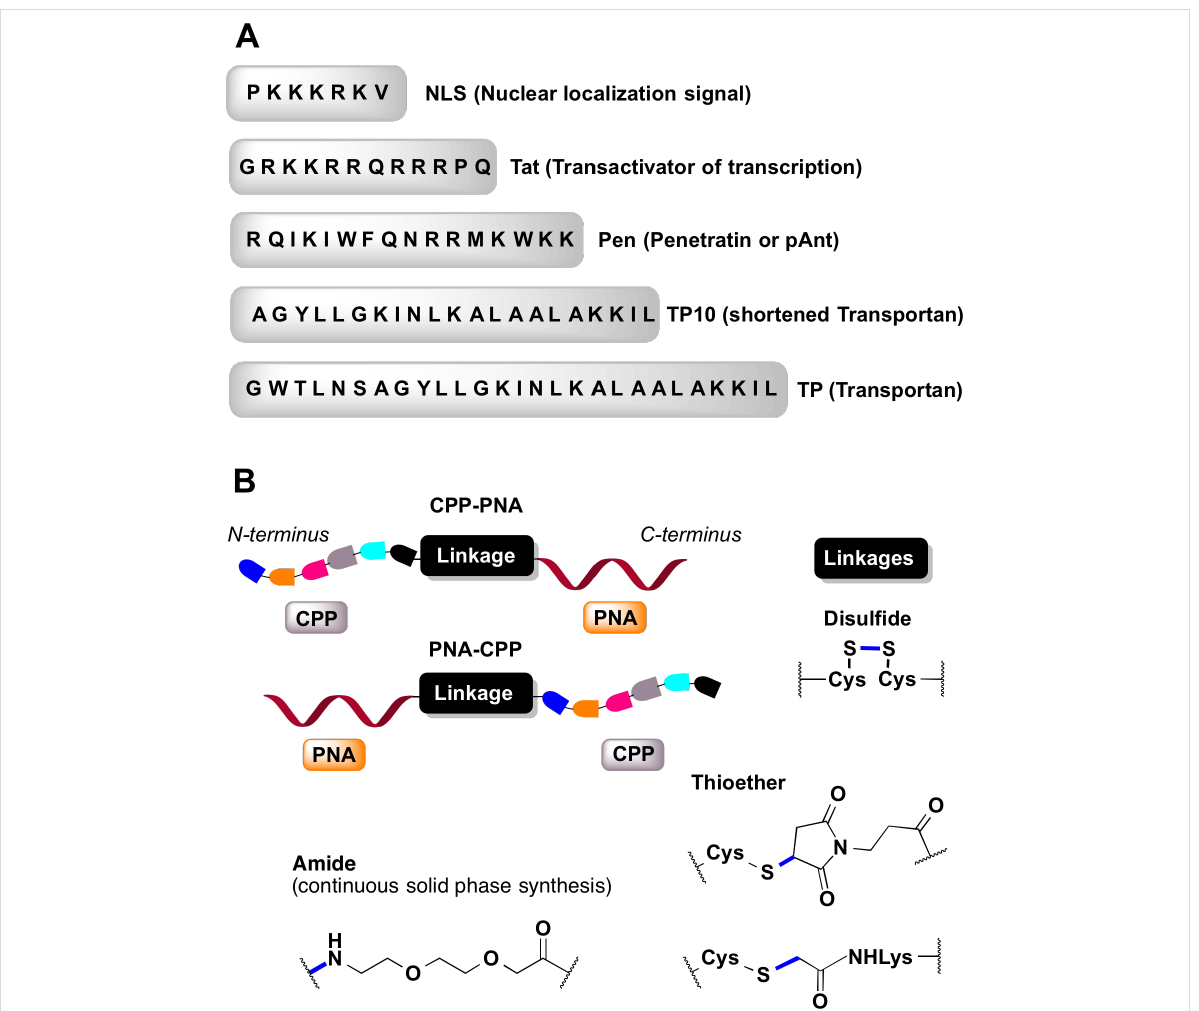
Figure 12: (A) representative cell-penetrating peptides (CPPs), (B) conjugation designs and linker chemistries.